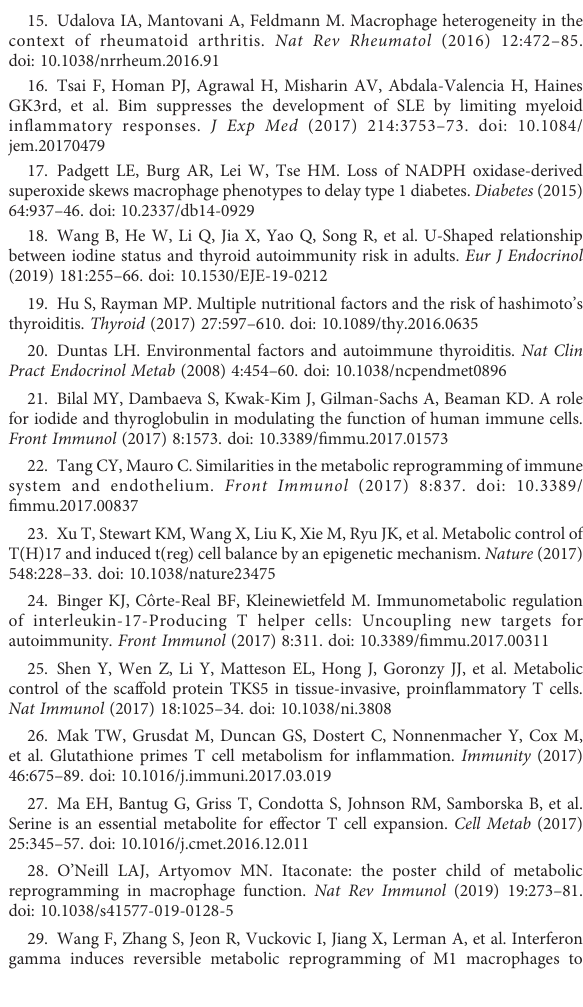
SUPPLEMENTARY FIGURE 2 Systems biology revealed the role of HK3 in the pathogenesis of GD. (A) HK3 expression abundance in CD14 + monocyte-macrophages; (B) The proportion of major immune cells in 18 thyroid tissue in the GSE9340 dataset; (C) The relationship between HK3 and the proportion of M1 macrophages and M1/M2 ratio; (D) HK3-related co-expression gene modules by WGCNA analysis; (E) Darkred module was most correlated with HK3; (F) Heatmap of key genes of Darkred module; (G) GO analysis; (H) GSEA